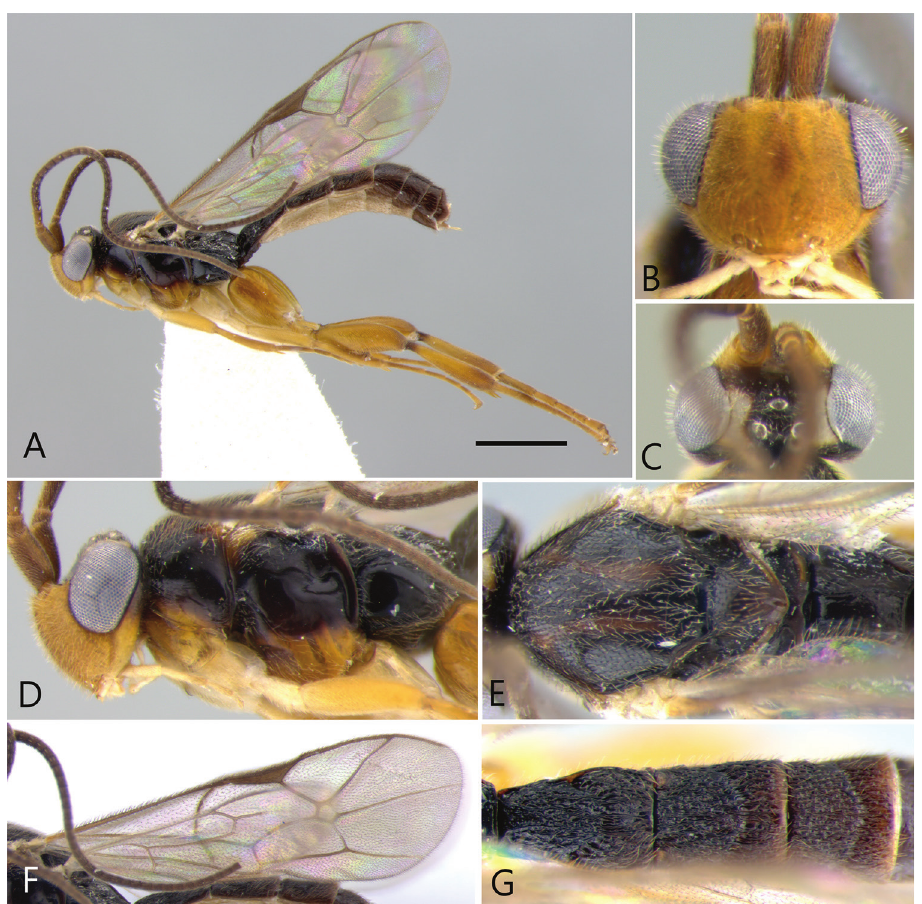
Figure 17. Orthocentrus trichophthalmus sp. nov. Holotype. A Habitus in lateral view B head in frontal view C head in dorsal view D head and mesosoma in lateral view E mesosoma in dorsal view F fore wing G first to third tergites in dorsal